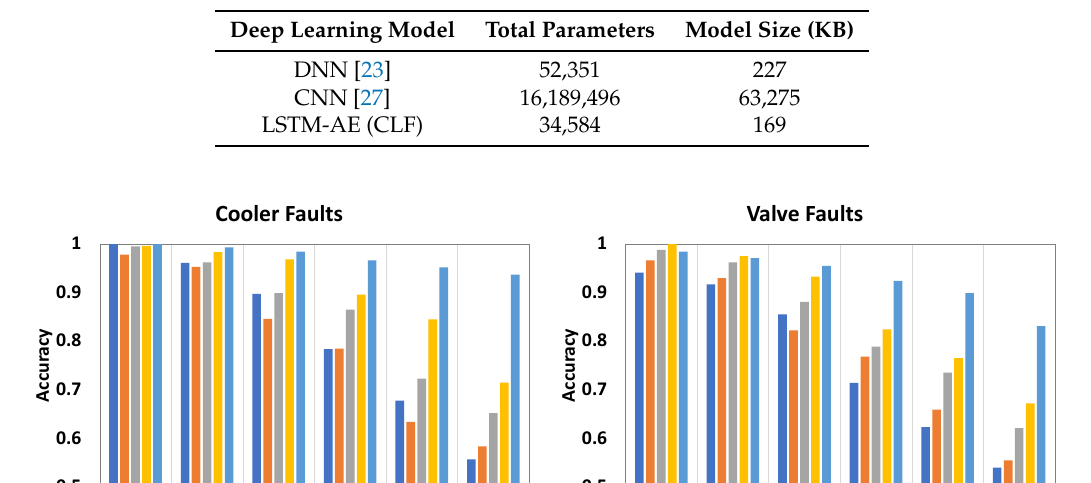
Table 9. Complexity of the deep learning models.